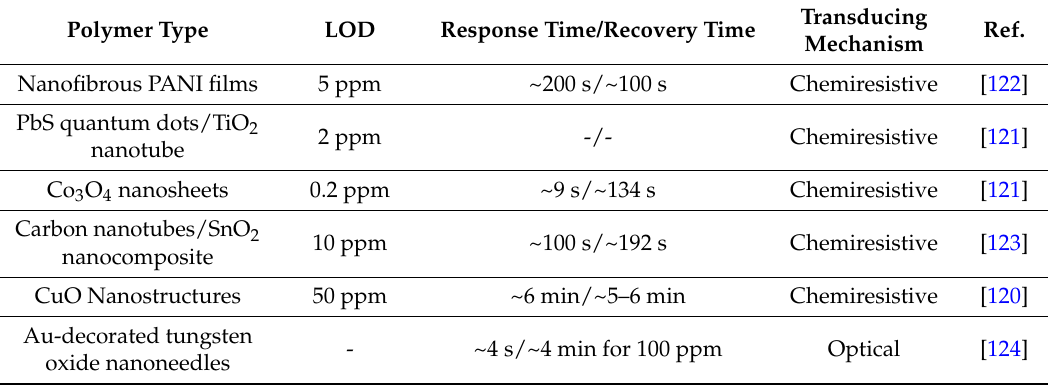
Table 4. Overview of different nanomaterials used as active layers for detection of ammonia at room temperature.